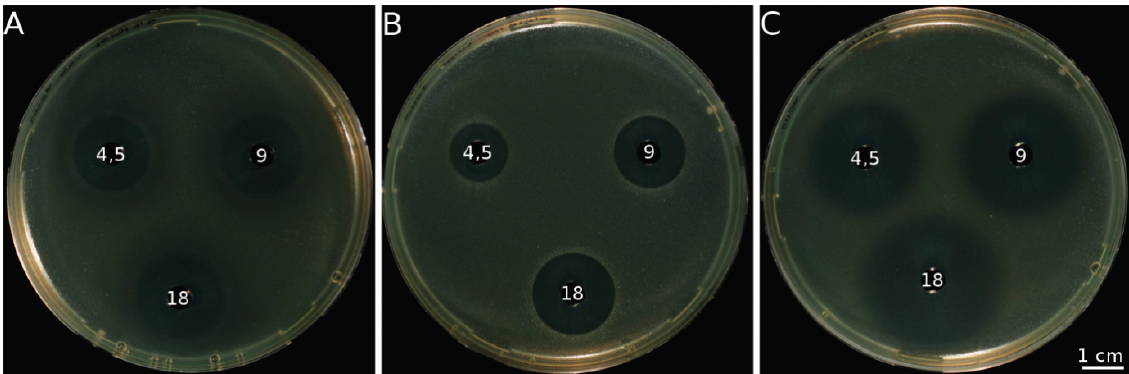
Figure 1. Plate diffusion test. Antibacterial activity against E. coli DH5 α demonstrated on seeded agar plates by different antibiotics is indicated by clear zones where growth inhibition has occurred. Freshly grown E. coli cells (OD = 0.2, 300 µL) were embedded 600 in 20 mL warm agar in a Petri dish (diameter 9 cm). Afterwards, holes (diameter 0.6 cm) were punched out and filled with 40 µL of antibiotic solution at the mM concentrations indicated. Pictures were taken after 24 h of incubation in the presence of the